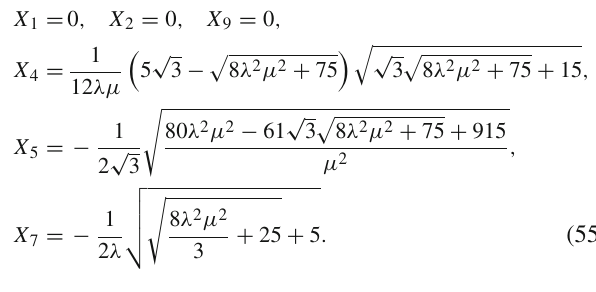
Fig. 3 The figure illustrates the relation between density parameter of non-vanishing fields and free parameters, i.e., λ and μ , for F point.Notedthatthegreen,black,blueandredlineinthegraphindicates (cid:12) (cid:12) φ , (cid:12) η and (cid:12) ρ , respectively A , m 1